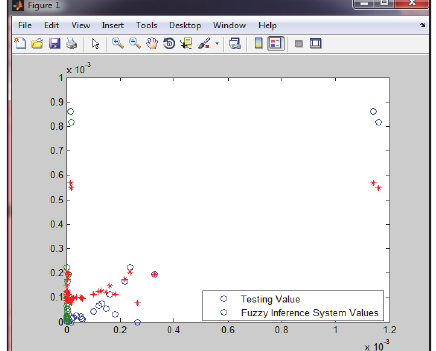
Fig. 10. Displaying real values and the values Fig. 11. Displaying real values and the values calculated by the market risk model for testing calculated by the liquidity risk model for testing data data